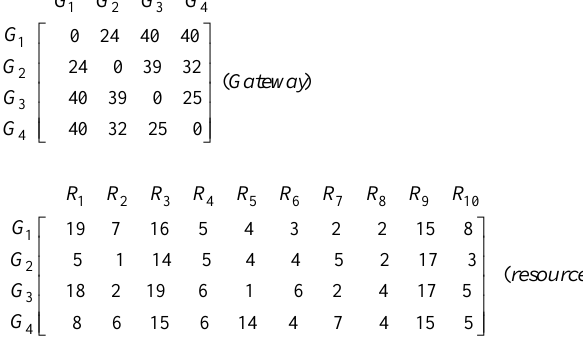
Figure 4. Dataset 1 D S . Figure 4. Dataset DS